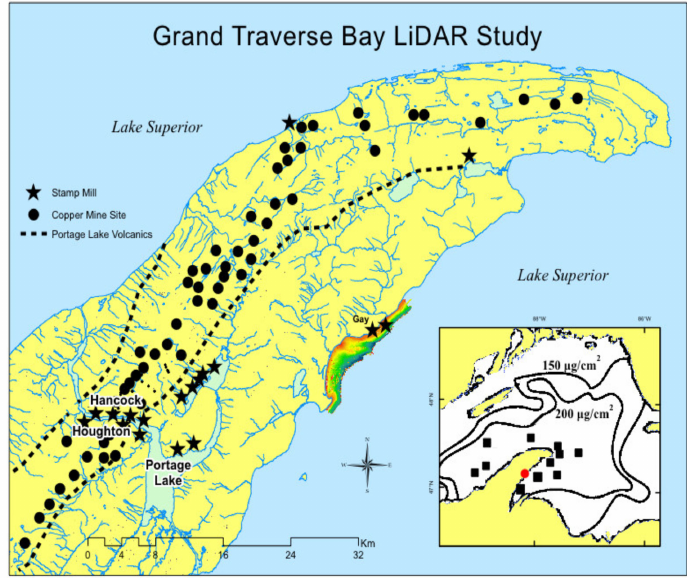
Figure 1. Geographic location of Grand (Big) Traverse Bay (red to green contours) along the eastern shore of the Keweenaw Peninsula, Michigan. On the Peninsula, early copper mines are indicated by black dots and stamp mills by stars (after Kerfoot et al. 2012). Insert shows anthropogenic copper inventory “halo” around the Peninsula, in µ g/cm 2 copper (modified from